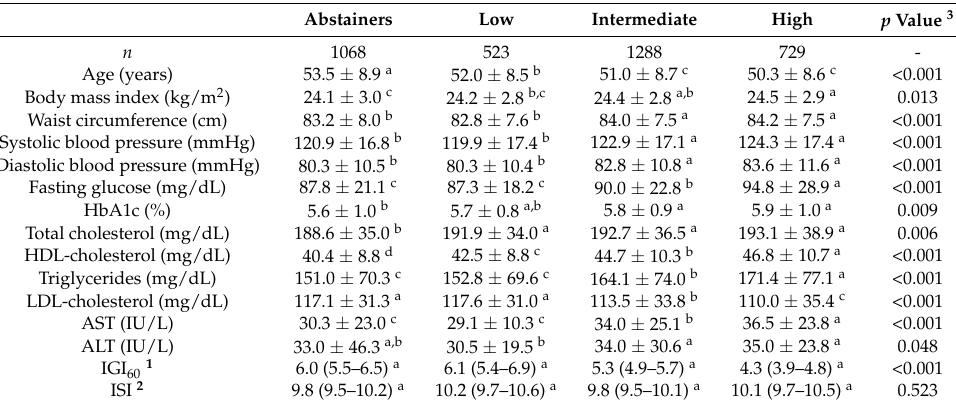
Table 2. Clinical characteristics according to alcohol consumption in men.